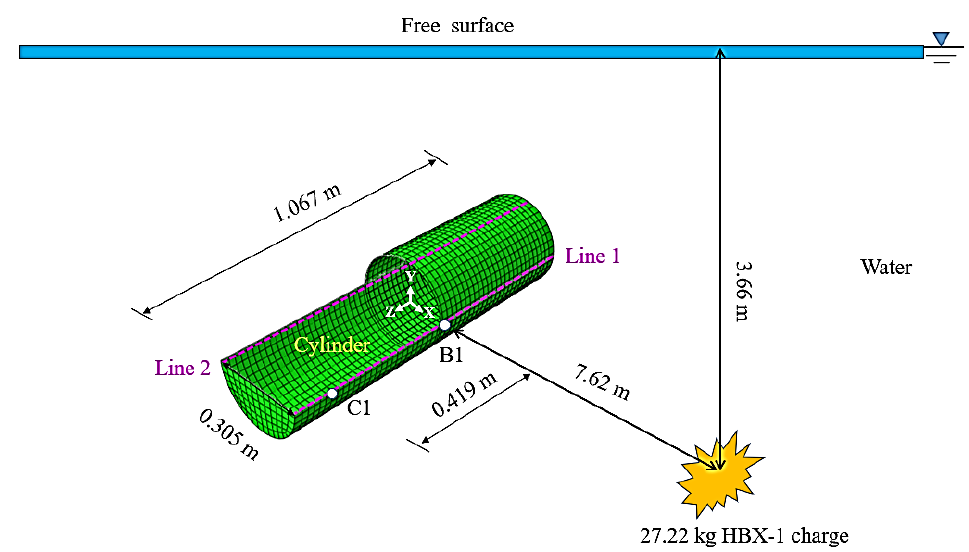
Figure 4. Three-dimensional diagram of UNDEX test with layout of monitoring points (B1, C1) and monitoring lines (line 1, line 2).